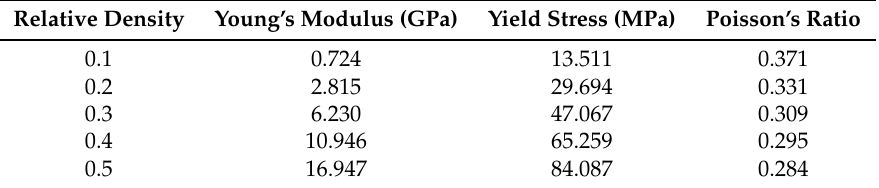
Table 2. Results from scaling laws for Young’s modulus, yield stress and Poisson’s ratio derived from Equations (5), (7) and (9) respectively.